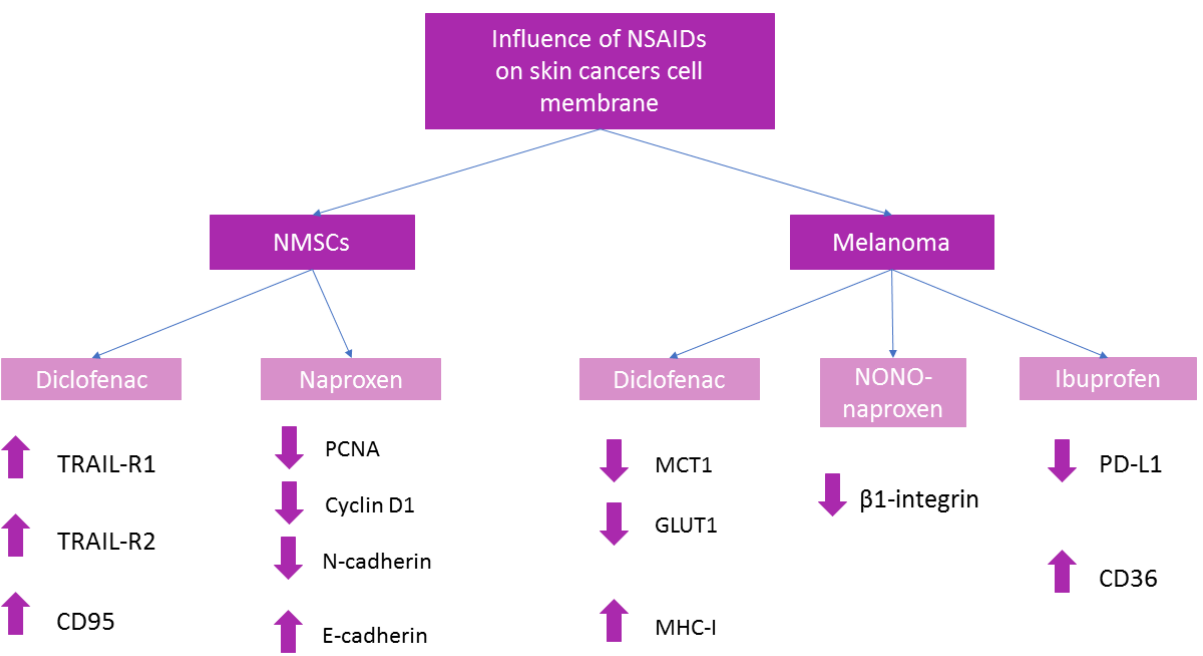
Figure 4. Summary of non-opioid analgesics influence on the melanoma plasma membrane. Non- melanoma skin cancers (NMSCs), nitric oxide-releasing naproxen (NONO-naproxen), factor-related apoptosis-inducing ligand receptor 1 (TRAIL-R1), factor-related apoptosis-inducing ligand receptor 2 (TRAIL-R2), cluster of differentiation 95 (CD95) [24], proliferating cell nuclear antigen (PCNA) [31], monocarboxylate transporter 1 (MCT1), glucose transporter 1 (GLUT1) [35], major histocompatibility complex class I (MHC-I) [37], programmed death-ligand 1 (PD-L1) [44,45], cluster of differentiation 36 (CD-36) [47].